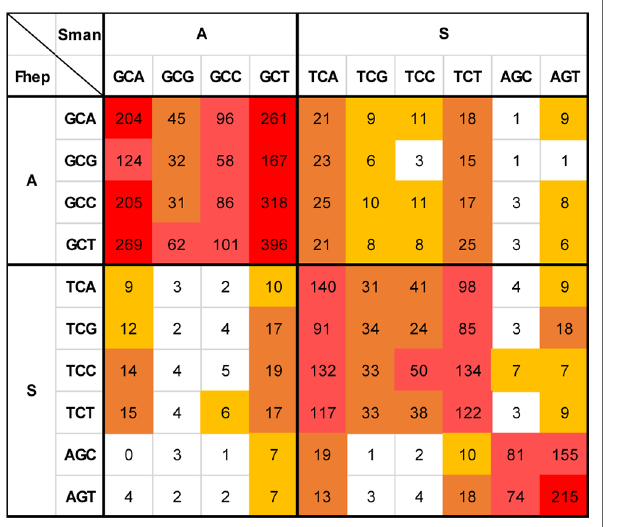
FIGURE 9 | Non-synonymous changes between S. mansoni and F. hepatica. Detail of the substitution matrix of Supplementary Table 3 of the changes involving Ala and Ser ( S. mansoni codons in columns, F. hepatica in rows). Note the lower-than-expected counts of changes toward GC3-rich codons and the enrichment in synonymous substitutions that imply two